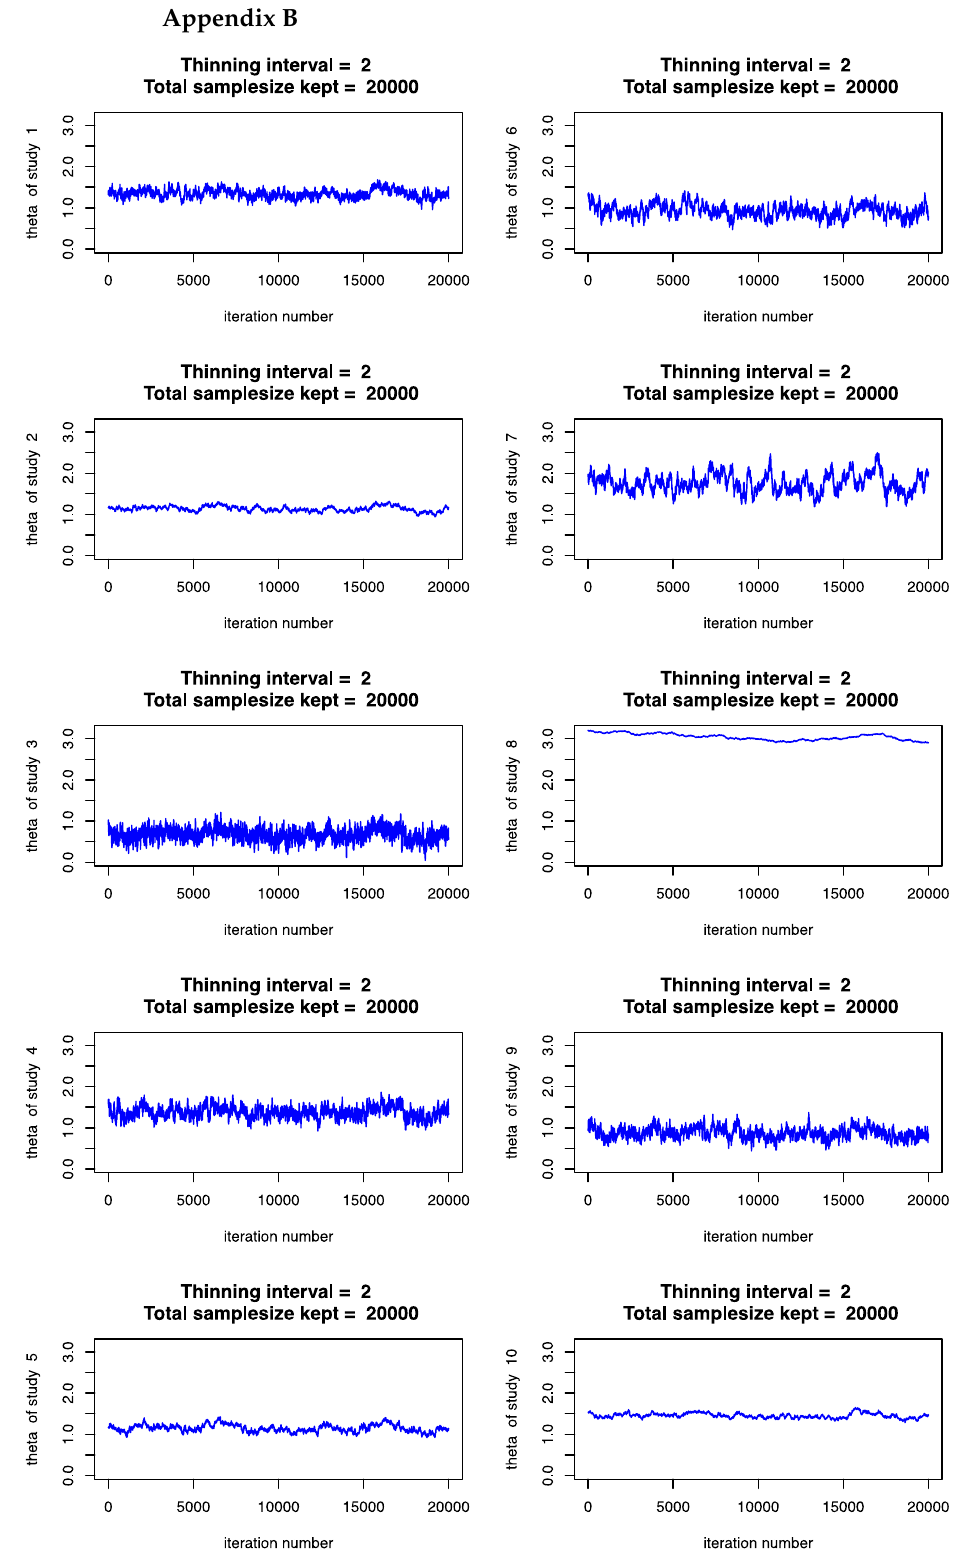
Figure 1. Convergence of Priori Distributions.